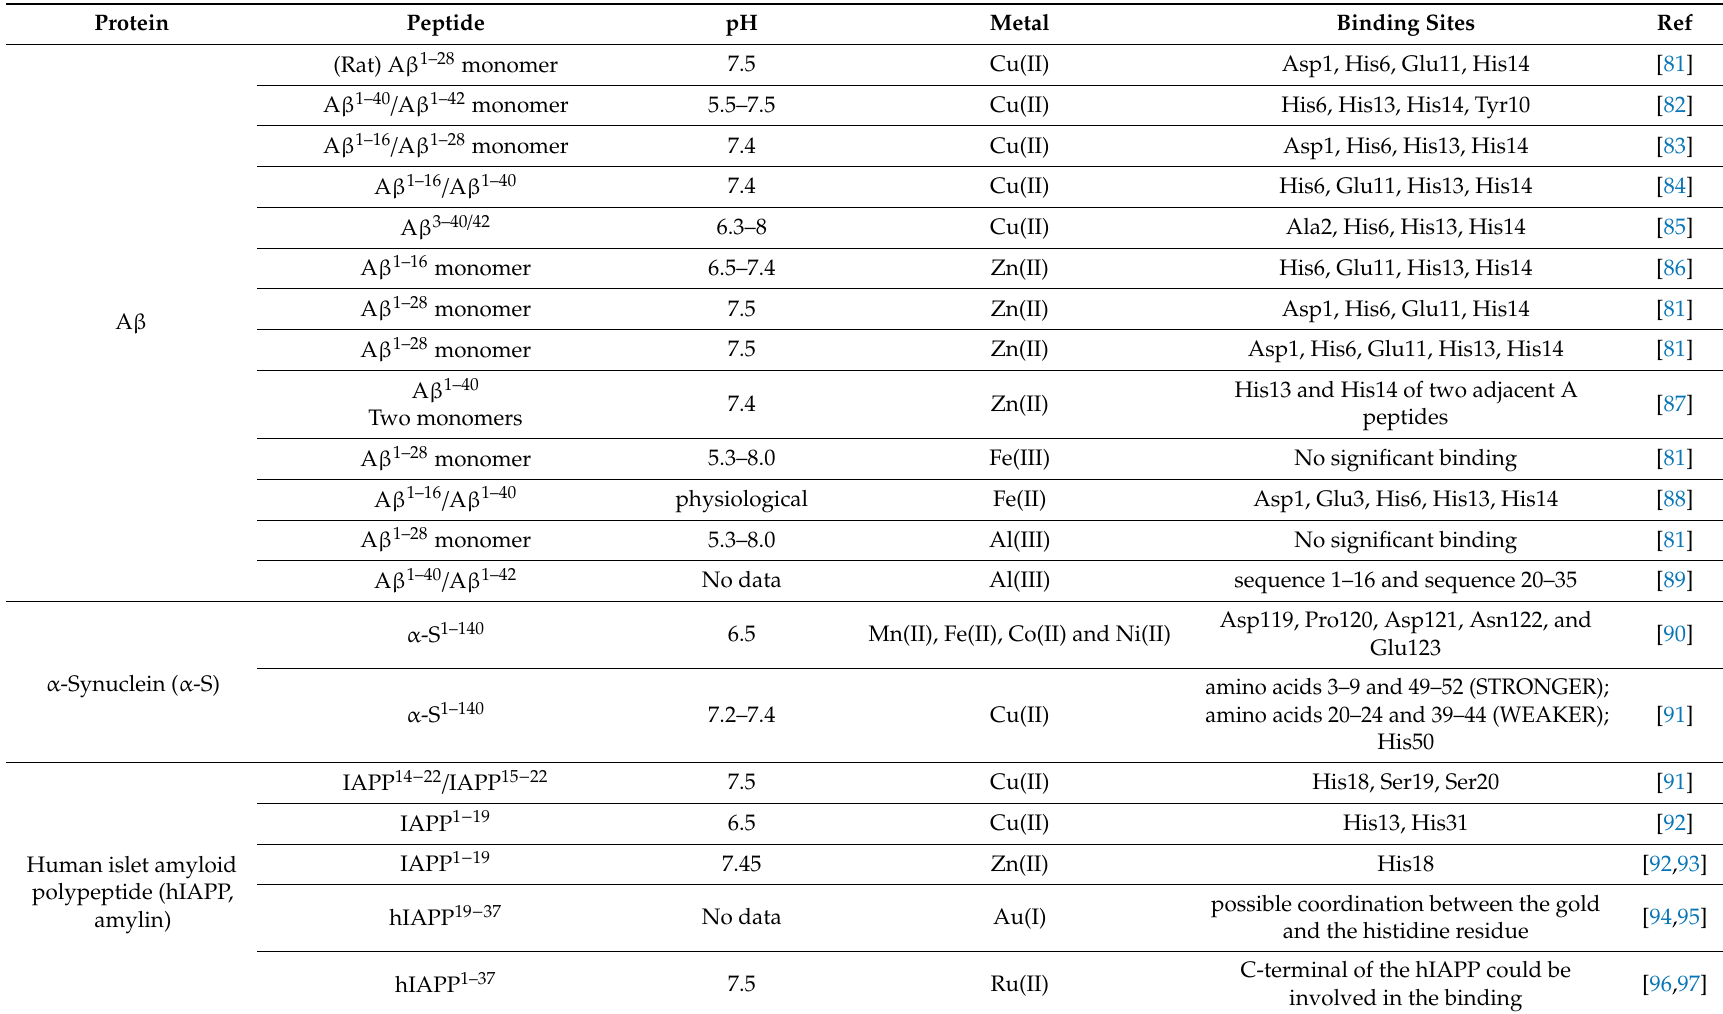
Table 1. Reported metal ions / amyloids interactions with identified binding sites and the condition of their